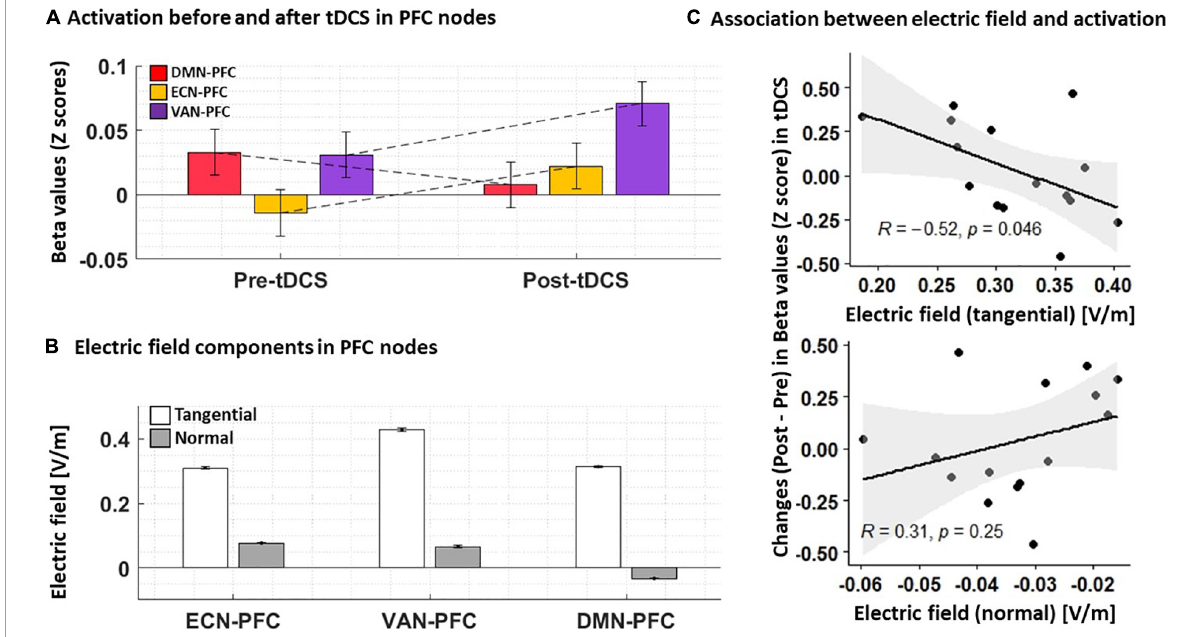
FIGURE6 (A) Functional activation before and after tDCS. Normalized beta values (Z score) obtained from first-level general linear models for each individual in PFC nodes are visualized pre- and post-tDCS. (B) Electric field components. Tangential and normal components of the electric fields in PFC nodes are extracted for each individual. (C) Association between changes in neural activation and electric fields. A Scatter plot for the PFC node in DMN showed a significant correlation between changes in neural activation and the tangential component of the electric field. Bars show average values, and error bars indicate standard errors.